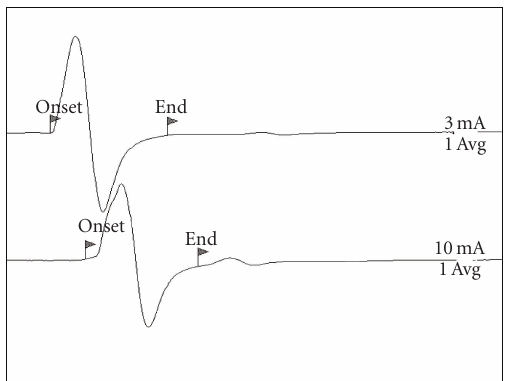
Figure 2: MNCS of the left sciatic-tibial nerve on ferret N.2. 2ms/Div; 5